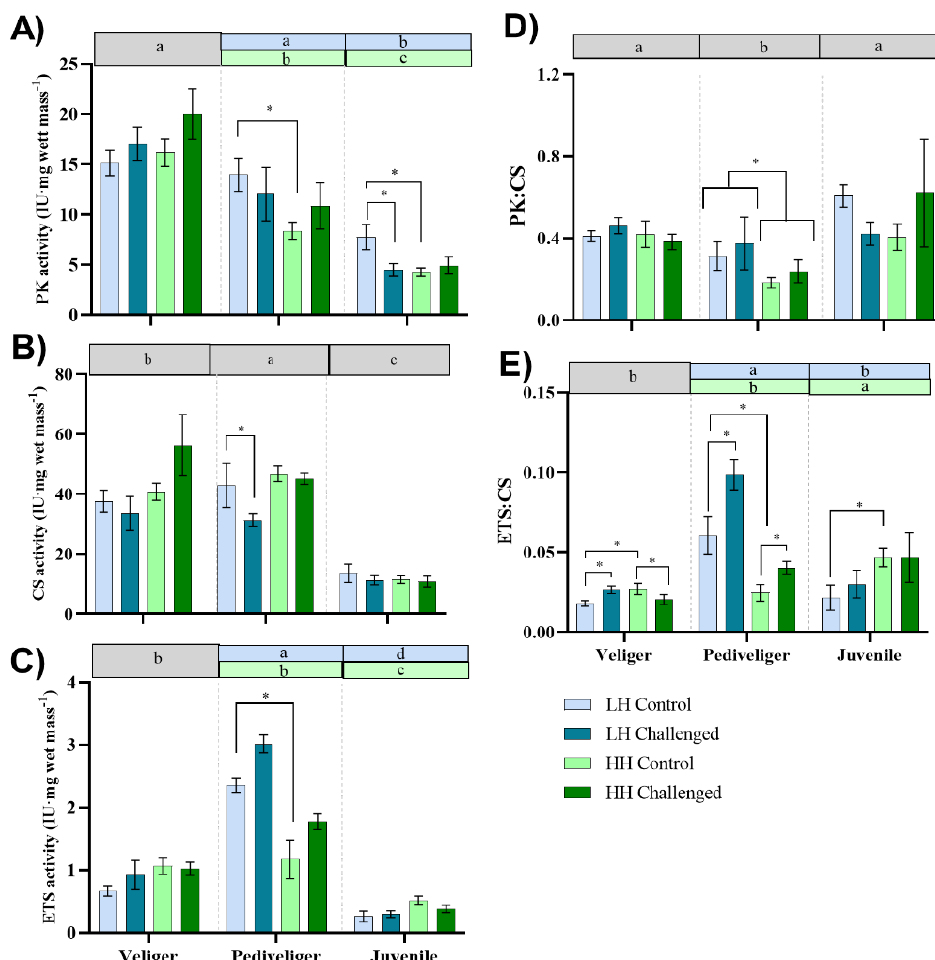
Figure 2. Effect of diets low (LH) and high (HH) in HUFAs on the energy metabolism of larvae and juveniles of the scallop Argopecten purpuratus under unchallenged (control) and Vibrio splendidus (VPA18)-challenged conditions. Energy metabolism was measured via the activity of key metabolic enzymes and their ratios: ( A ) pyruvate kinase (PK), ( B ) citrate synthase (CS), and ( C ) electron transport system (ETS) activities; and ( D ) PK:CS (anaerobic to aerobic capacity) and ( E ) ETS:CS (an indicator of mitochondrial efficiency) ratios. Different lowercase letters show significant differences among developmental stages (gray bars) or diet (blue/green bars) ( p < 0.05). Asterisks (*) indicate significant differences between treatments within each developmental stage ( p < 0.05); n = 6 pools per